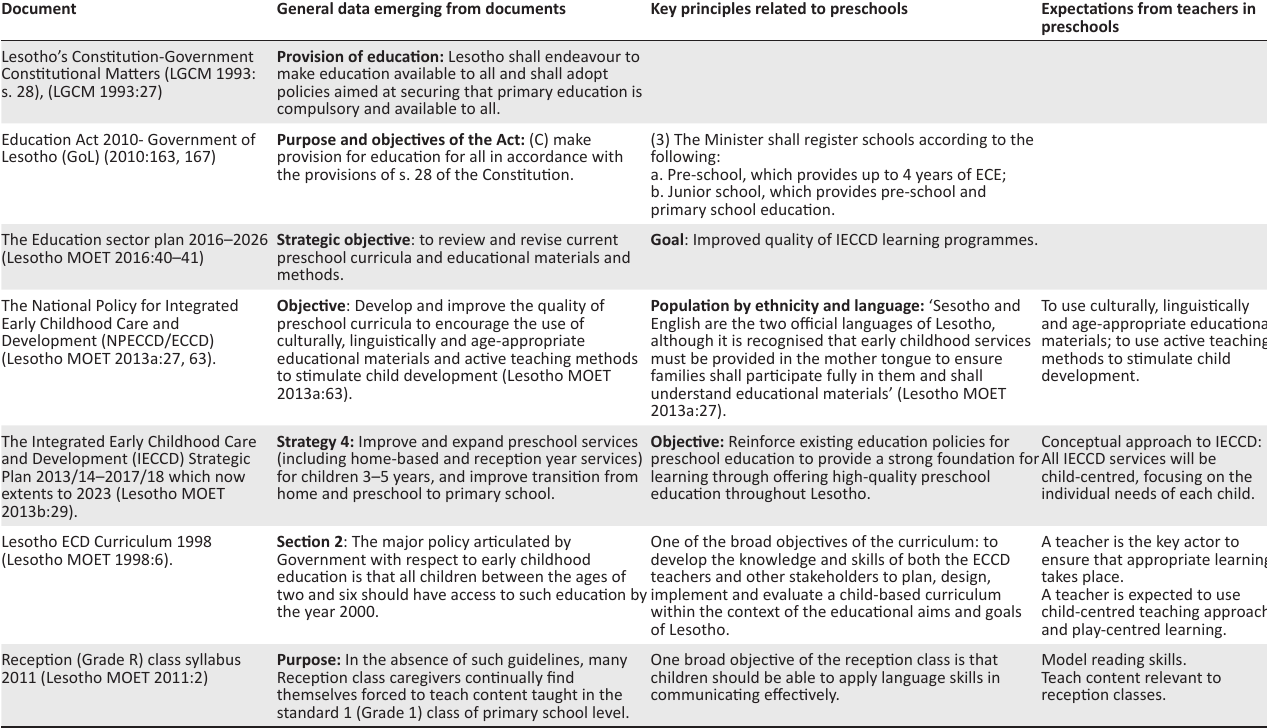
TABLE 2: Legal documents and policies that provided the data.